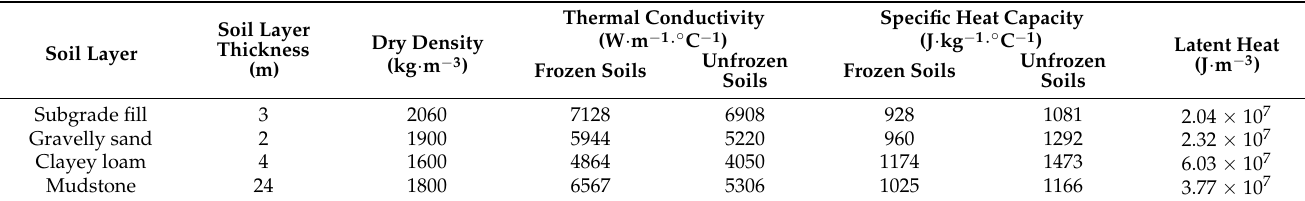
Table 3. Thermophysical parameters of different soils.